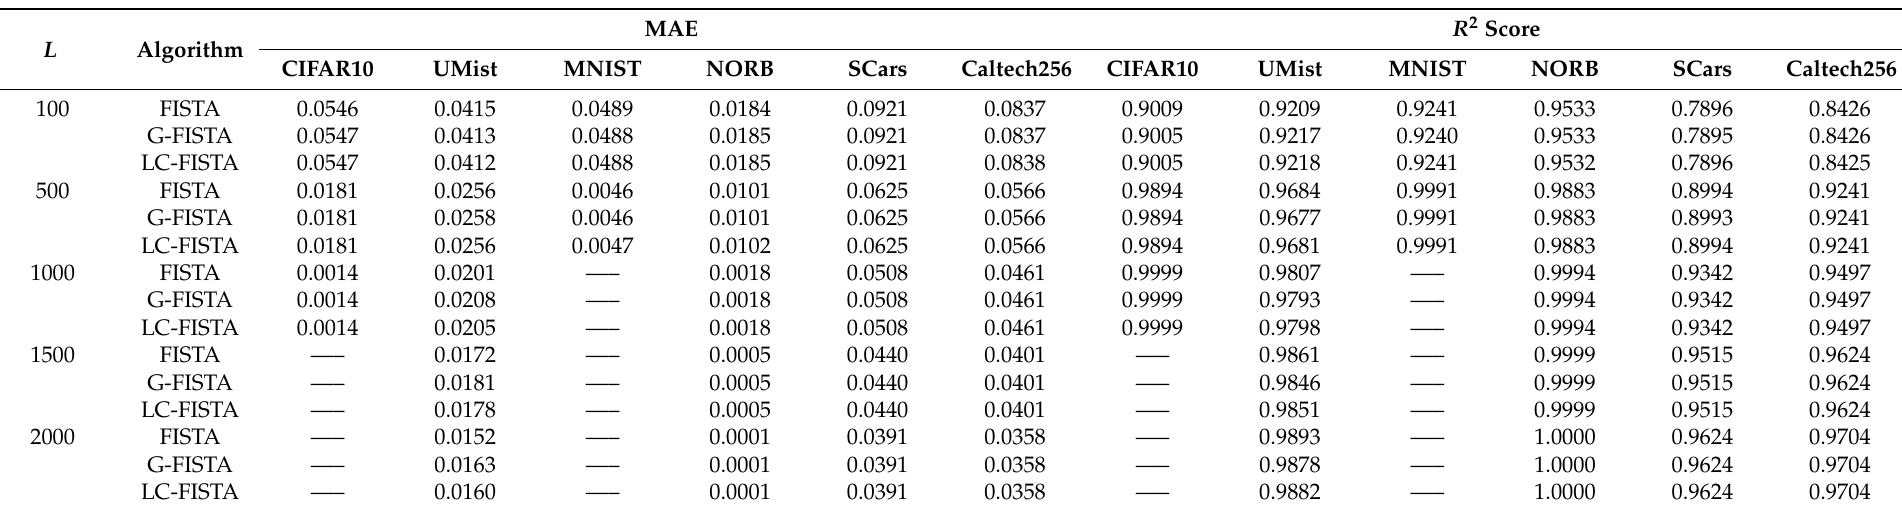
Table 5. MAE and R 2 score values achieved by FISTA, G-FISTA and LC-FISTA for training of the ELM-AE.